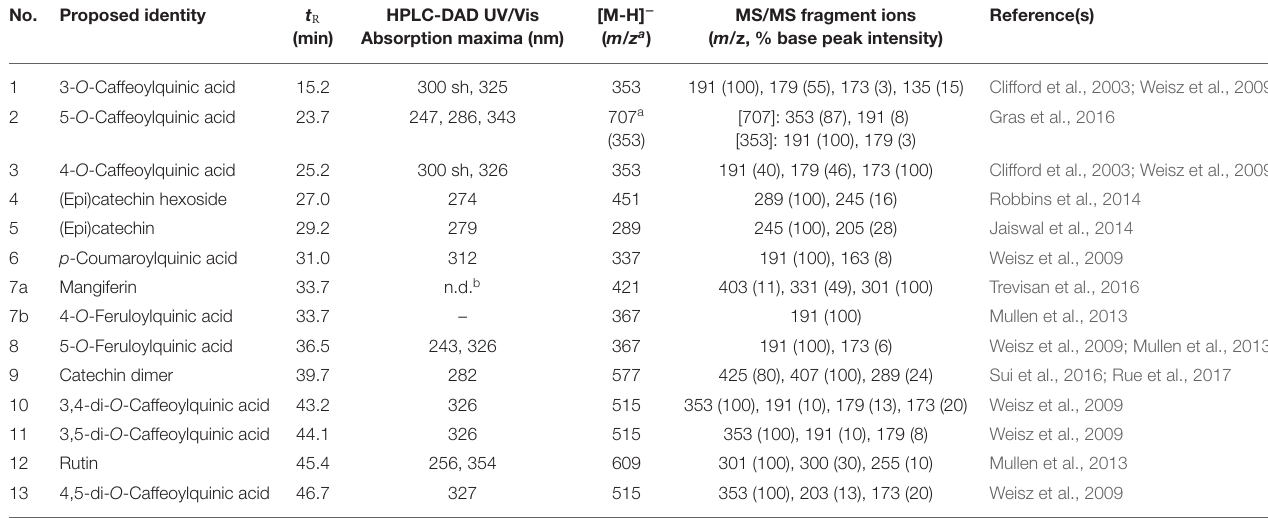
TABLE 1 | HPLC retention times ( t R ), UV/Vis and ESI-MS spectral data of non-anthocyanin phenolic compounds from pooled samples of coffee peels and pulp. No. Proposed